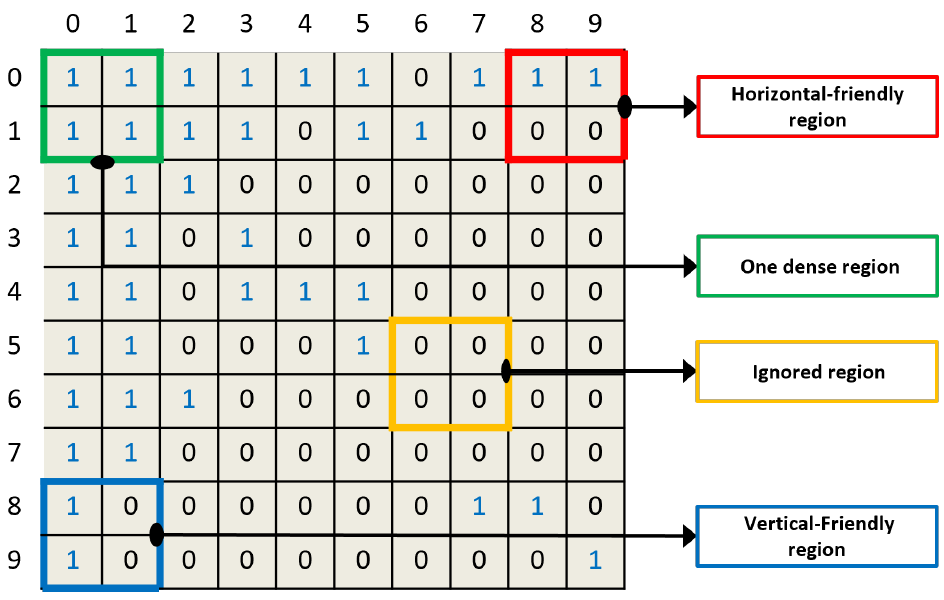
Figure 1. [Best viewed in color.] Compression-friendly regions of matrix M are shown in blue, green, and red